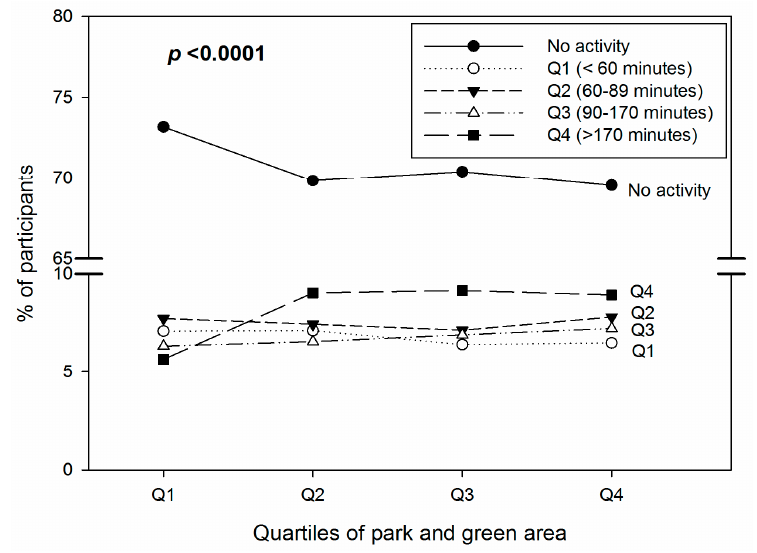
Figure 2. Percentages (%) of time of moderate physical activity (per week) by the quartiles of parks and green areas.